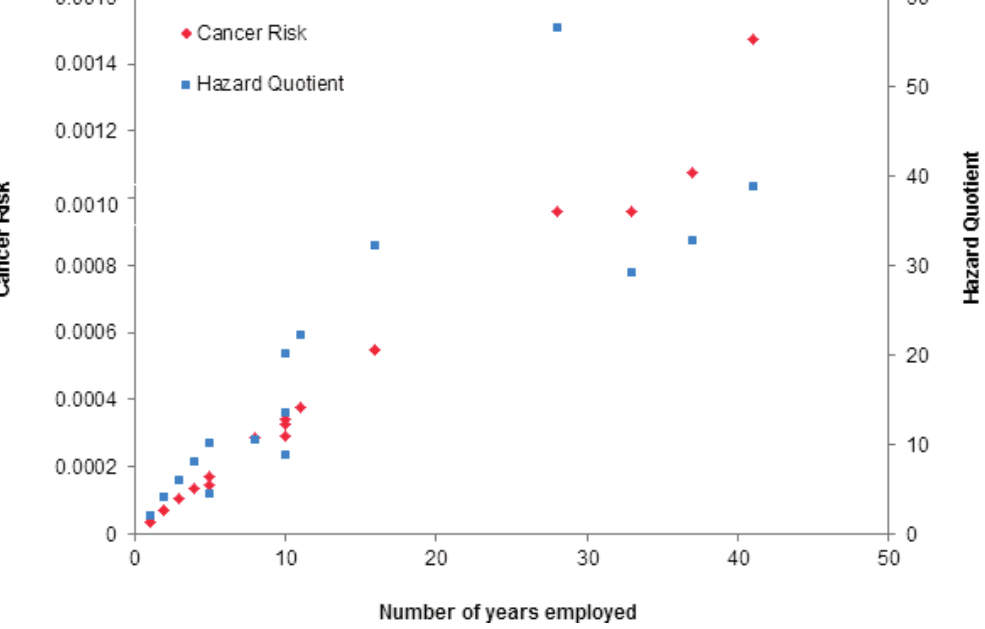
Figure 2. Cancer risk and hazard quotient (combined benzene, toluene and xylene hazard quotients) as compared to number of years